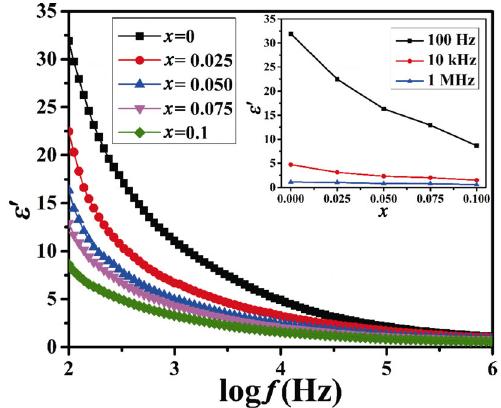
Fig. 7 Variation of real part of dielectric constant of Mn 0.5 Zn 0.5 Gd x Fe 2– x O 4 ( x = 0, 0.025, 0.050, 0.075, and 0.10) with frequency.